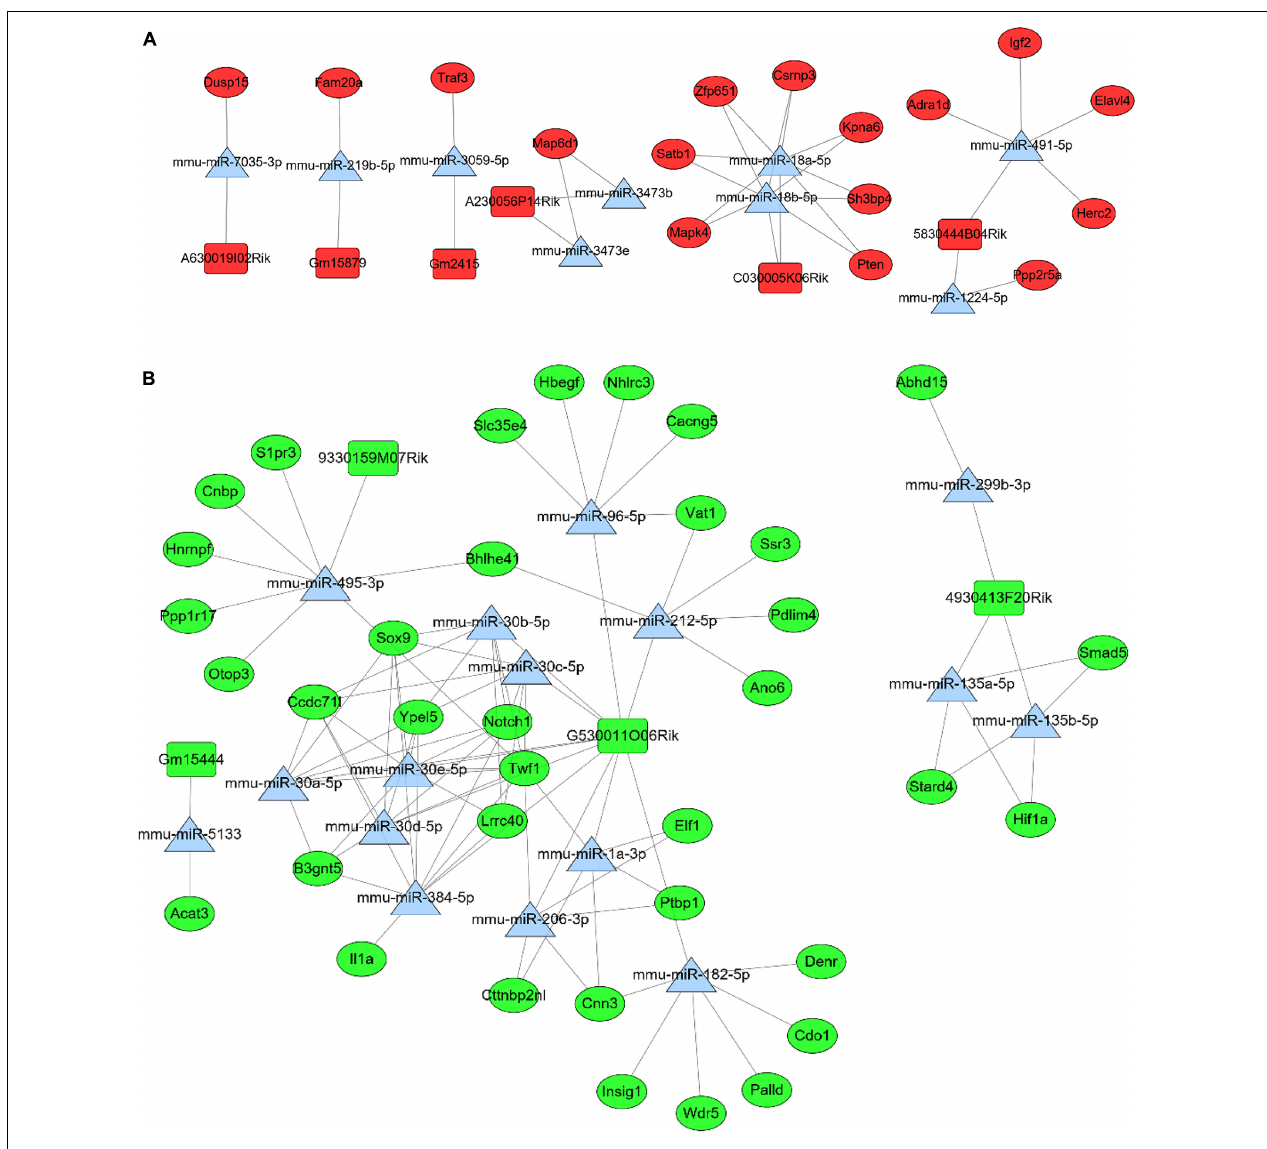
FIGURE 5 | In the ceRNA network, rectangles represent lncRNAs, triangles represent miRNAs, and circles represent mRNAs. And red represents up-regulated genes and green represents down- regulated genes. (A) The positive regulation network of lncRNA-miRNA-mRNA ceRNA. (B) The negative regulation network of lncRNA-miRNA-mRNA